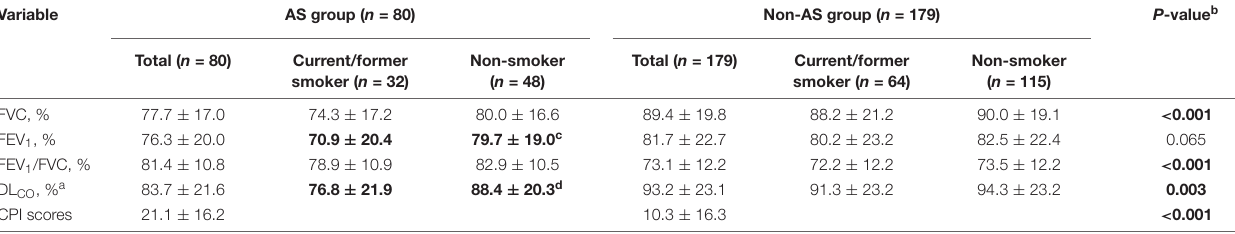
TABLE 2 | Baseline lung function characteristics with AS group versus non-AS group.